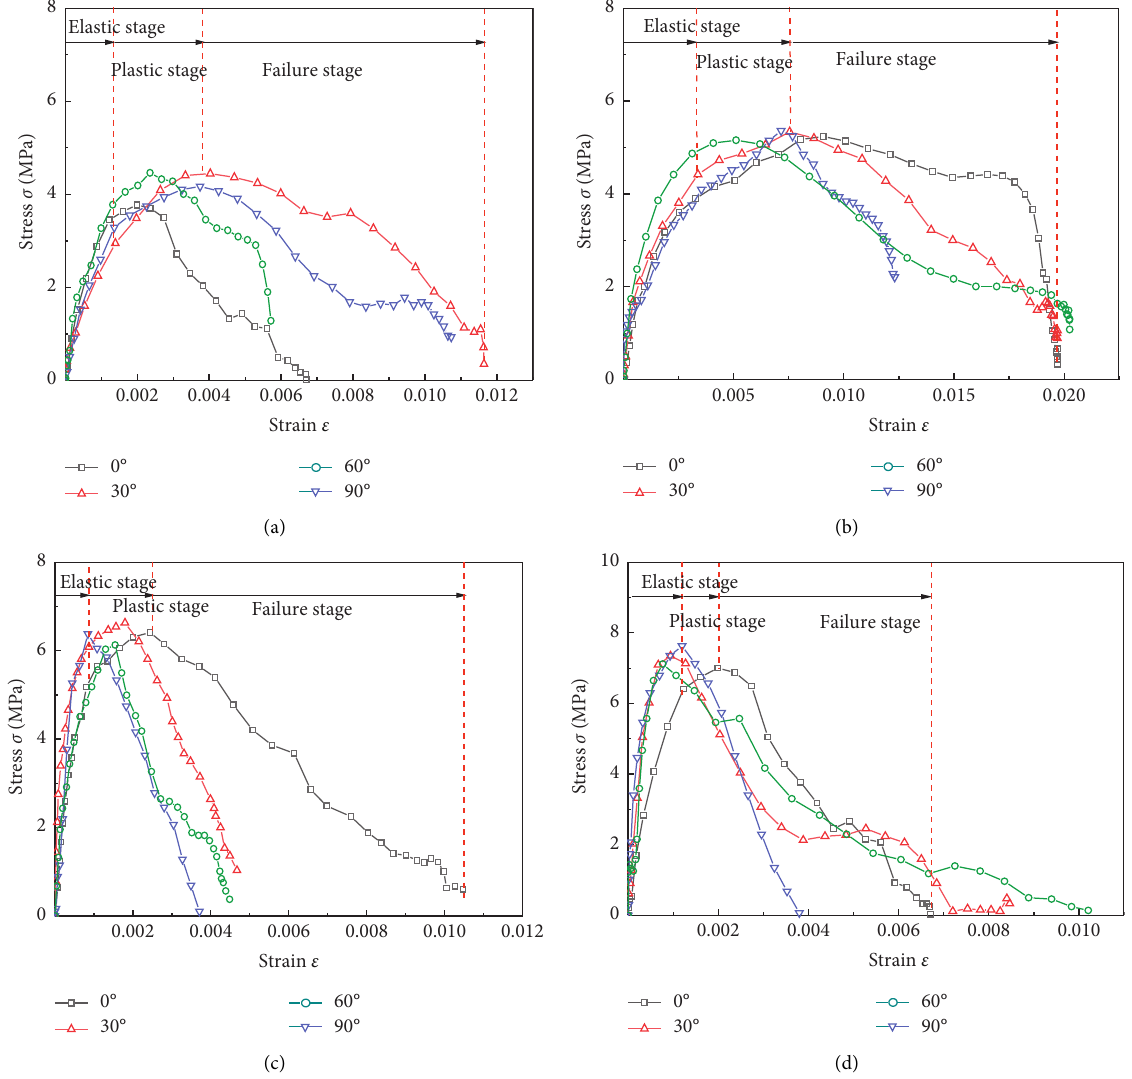
Figure 4: Dynamic splitting stress-strain curve of fractured sandstone at various fissure angles and subzero temperatures. (a) T � − 5 ℃ . (b) T � − 10 ℃ . (c) T � − 15 ℃ . (d) T � − 20 ℃